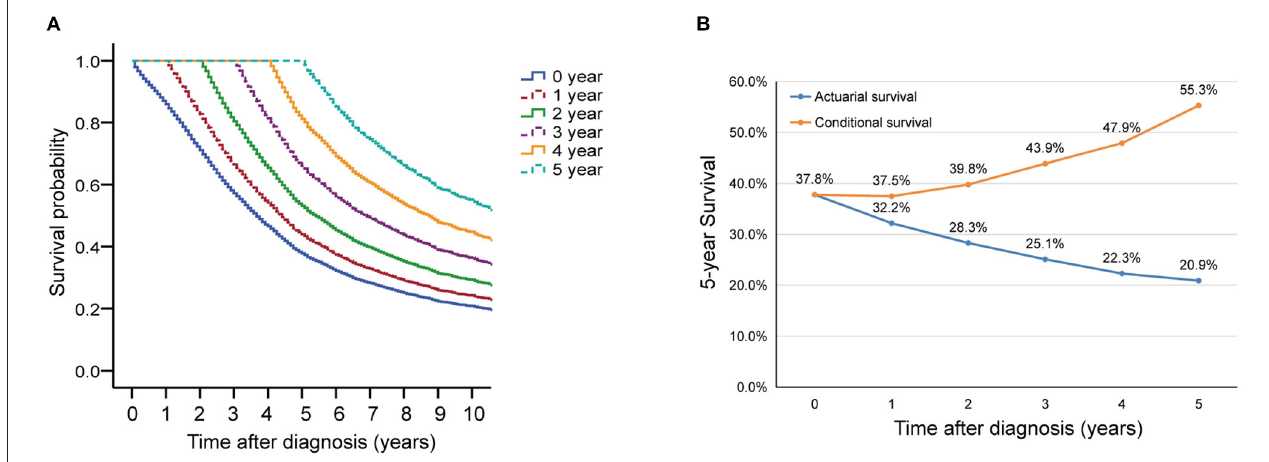
FIGURE 2 | Overall survival (OS) and conditional survival for all patients. (A) Kaplan-Meier estimates of survival at diagnosis (0 years) and conditional survival, according to years already survived after diagnosis (1–5 years). (B) 5 year conditional survival (CS5) and corresponding OS among paitients with advanced epithelial ovarian cancer.